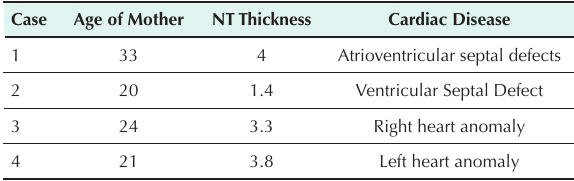
Table 3 . The Diagnosis of Prenatal Cardiac Disease